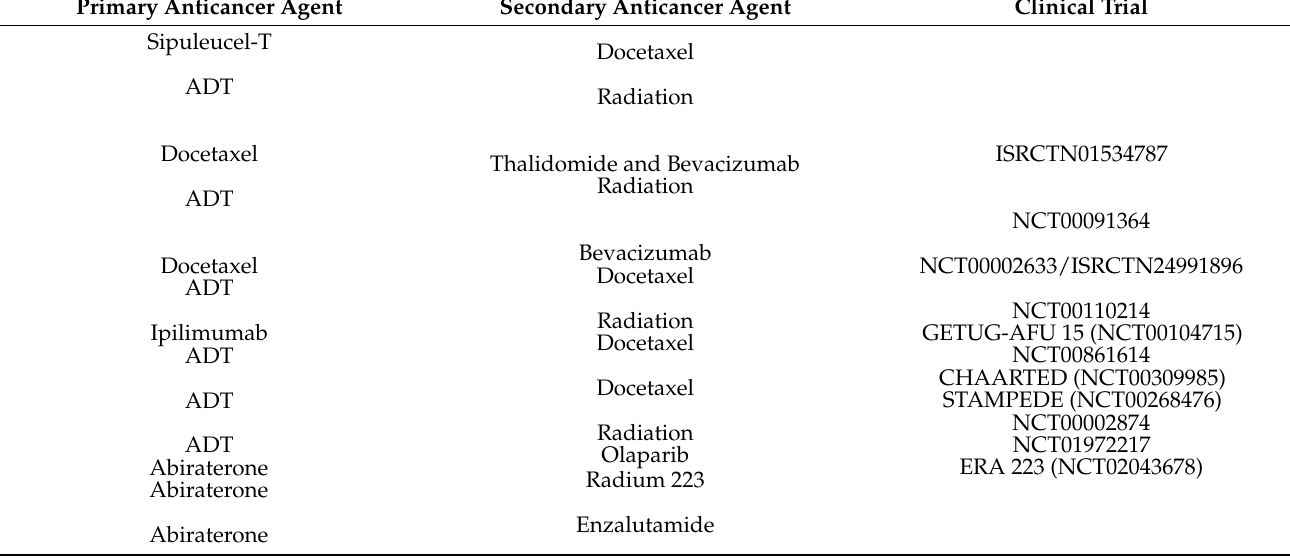
Table 5. Combination therapies for prostate cancer—completed clinical trials [116].